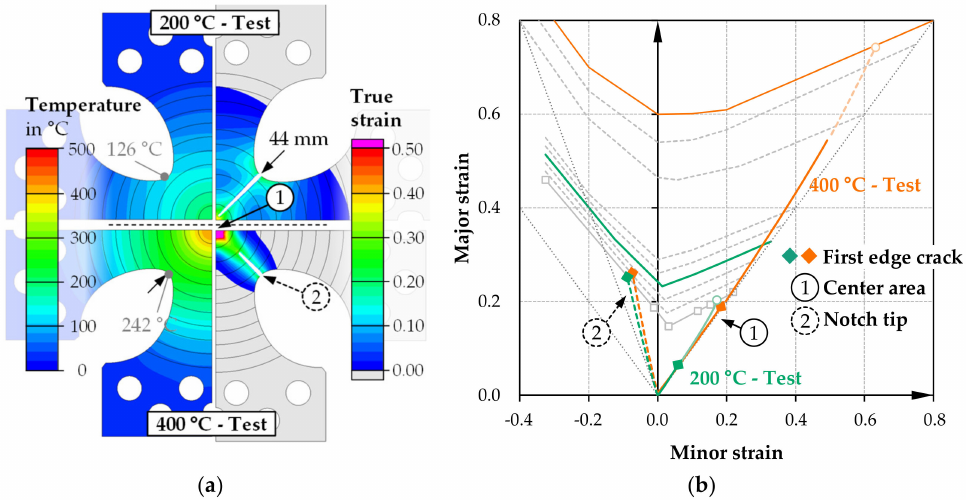
Figure 10. Simulation results of biaxial testing specimen B for 200 ◦ C and 400 ◦ C test: ( a ) temperature distribution at start of loading, plastic strain distribution immediately before center crack; ( b ) forming limit diagram with strain paths of center and notch tip